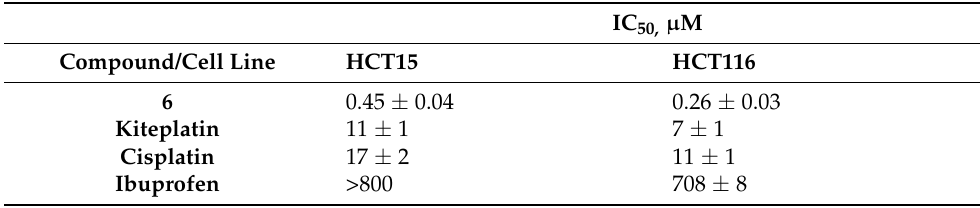
Table 6. Antiproliferative activity of kiteplatin, cisplatin, ibuprofen, and platinum prodrug 6 on HCT15 (human colon carcinoma) and HCT116 (colon adenocarcinoma) cells.